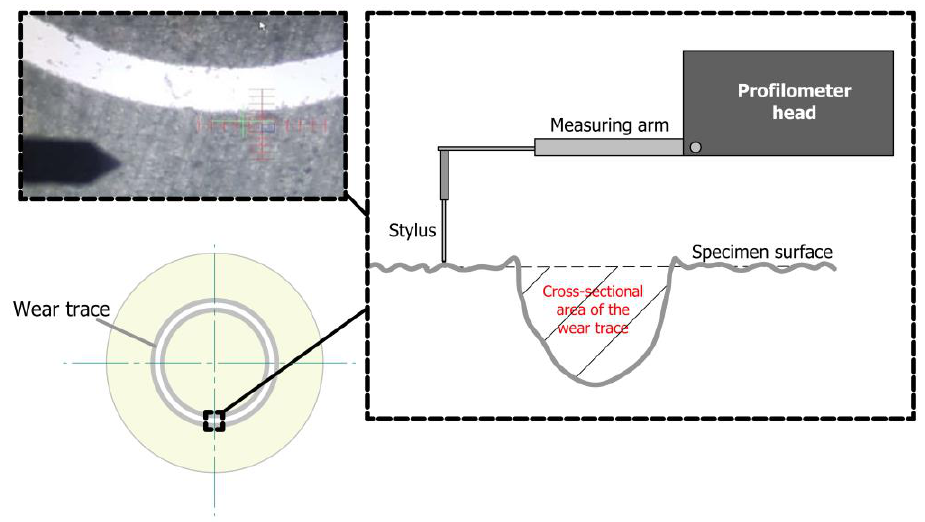
Figure 1. Measurement of the cross-sectional area of the wear trace of PA6 specimen on a contact (stylus) profilometer.